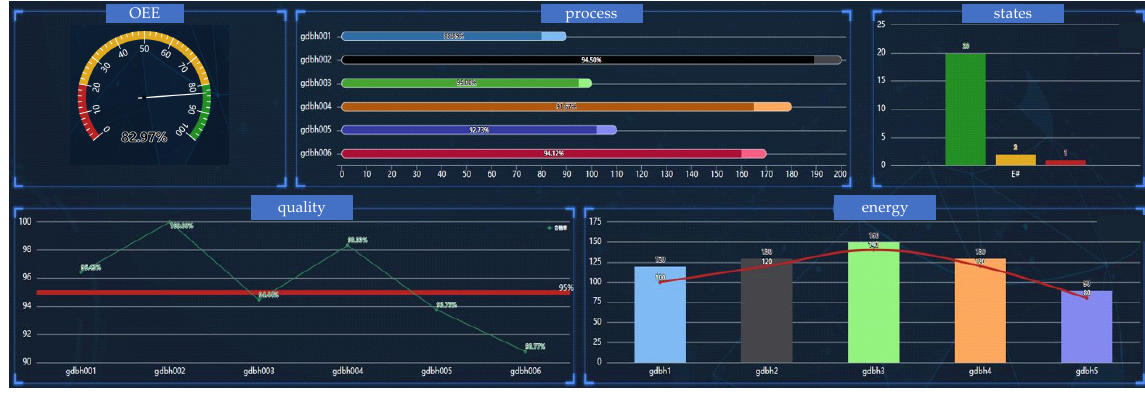
Figure 13. The OEE screen of the workshop.